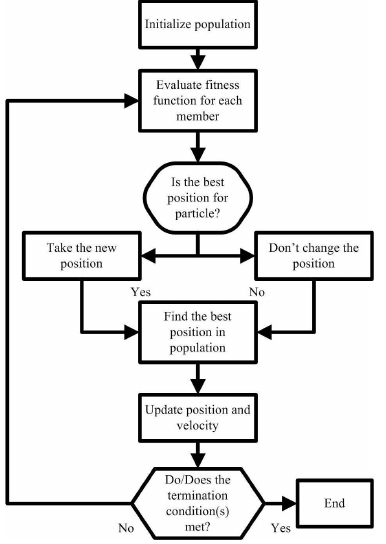
Figure 3. Flow-diagram of particle swarm optimization.